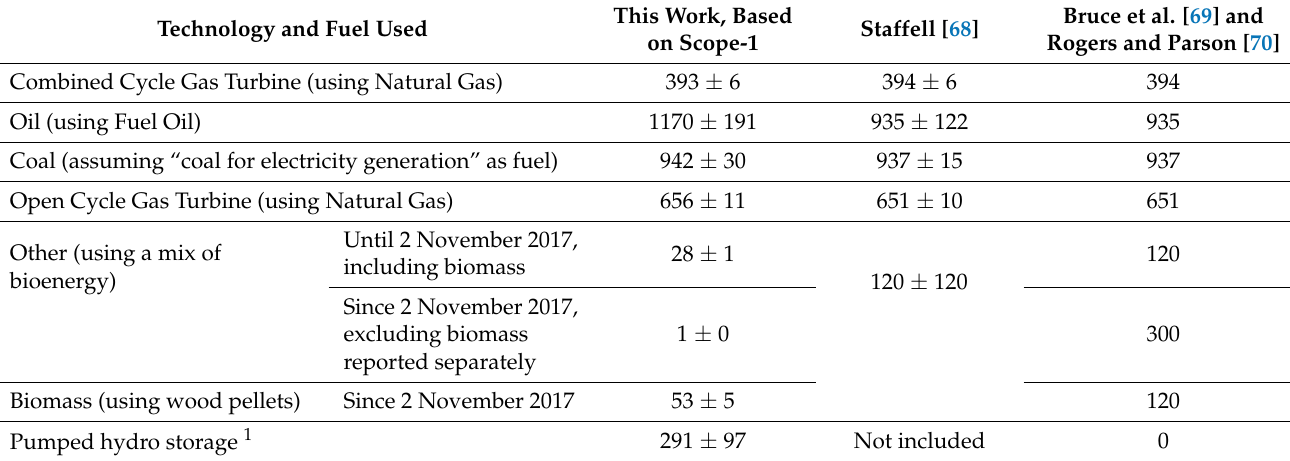
Table 3. CIs for electricity generation per fuel and technology, calculated according to the methodology in Section 2. The category “other” includes bioenergy sources, with biomass calculated separately since 2 November 2017. All values are in g · CO2eq /kW